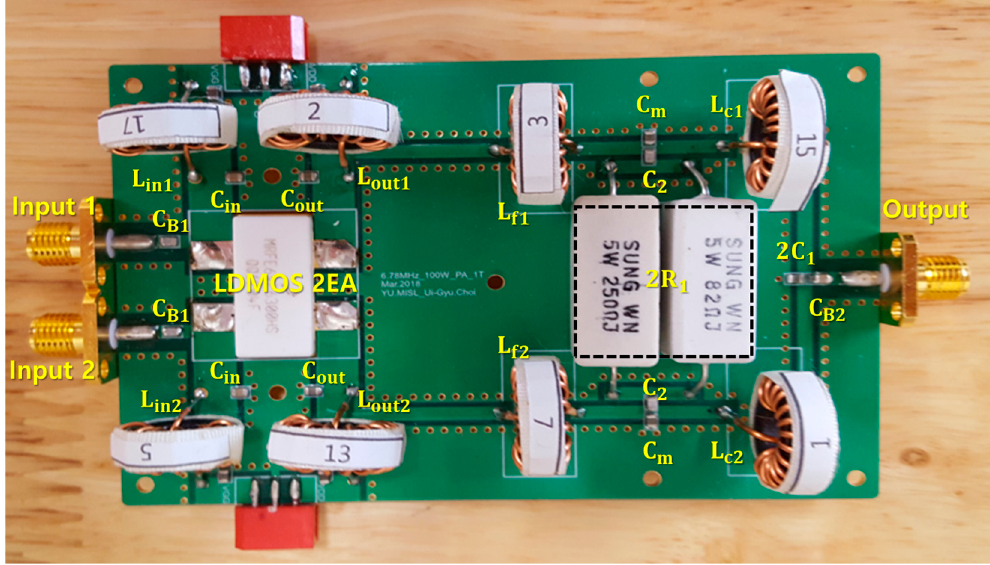
Figure 10. Photograph of the fabricated power module on FR4 PCB.